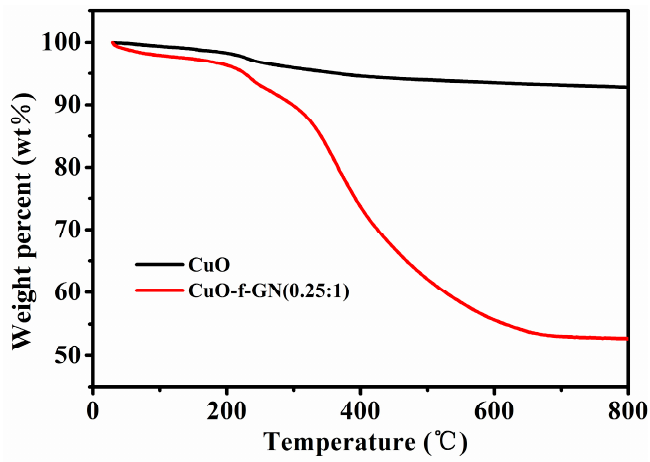
Figure 3. TGA curves of CuO powder and the CuO/f-graphene composite in air.